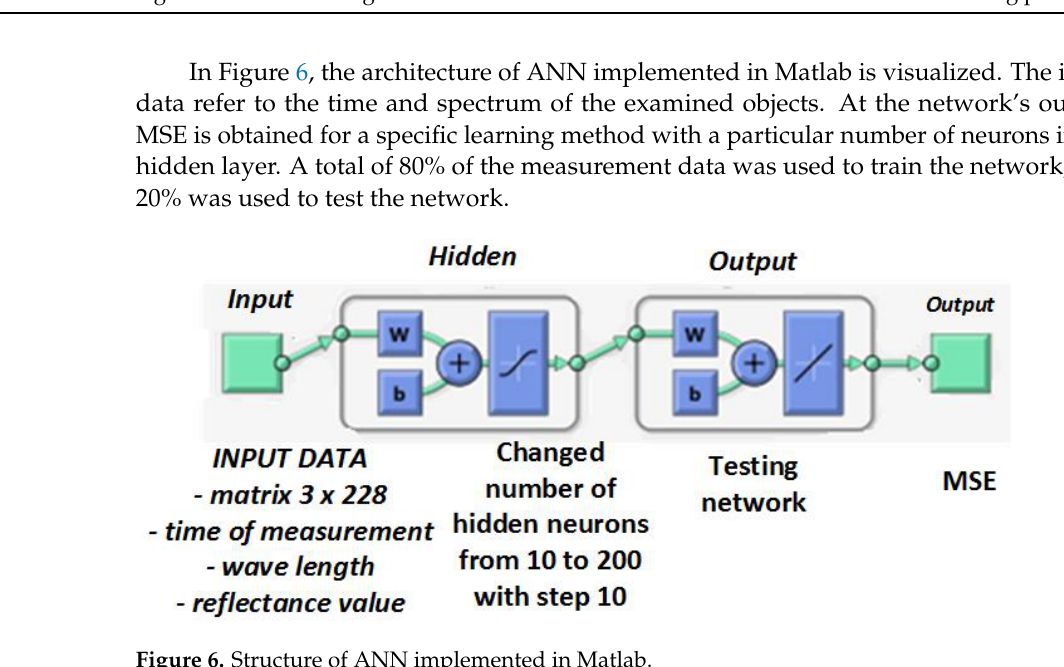
Figure 7. Dialog window of the Neural Network Training Matlab tool.